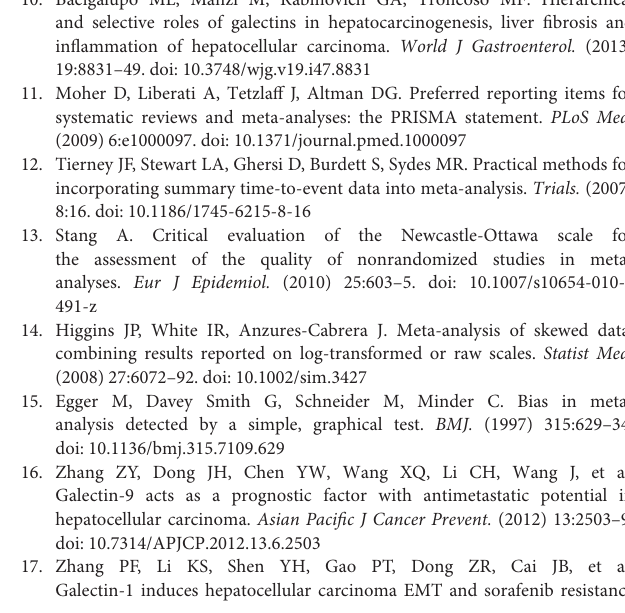
Supplementary Figure 1 | Sensitivity analysis of galectin-3 expression with overall survival (OS) in HCC. Supplementary Figure 2 | Sensitivity analysis of galectin-3 expression with TNM stage in HCC. Supplementary Figure 3 | Sensitivity analysis of galectin-3 expression with the differentiation grade in HCC. Supplementary Figure 4 | Sensitivity analysis of galectin-9 expression with the differentiation grade in HCC. Supplementary Figure 5 | Sensitivity analysis of serum galectin-3 level with the risk of HCC. Supplementary Table 1 | Publication